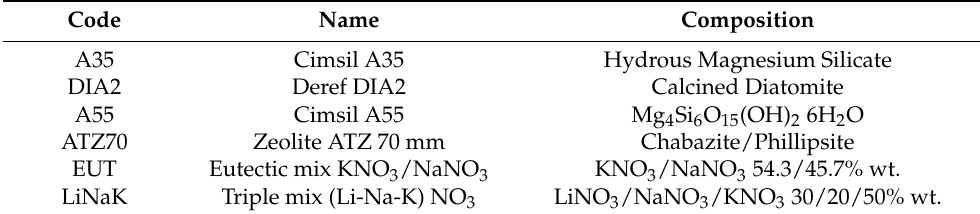
Table 1. Summary list of shape stabilizers and phase change